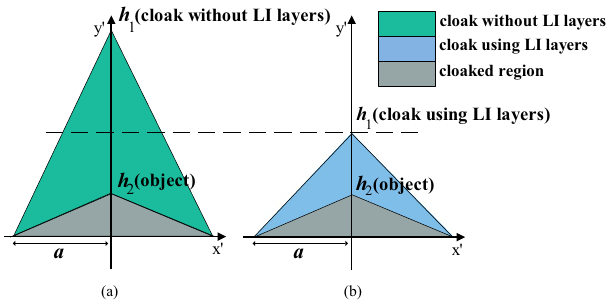
Figure 2. Comparison of two designed carpet cloaks. ( a ) The cloak without low index layers and ( b ) the cloak using low index layers. The cloak thickness is remarkably reduced in ( b ).